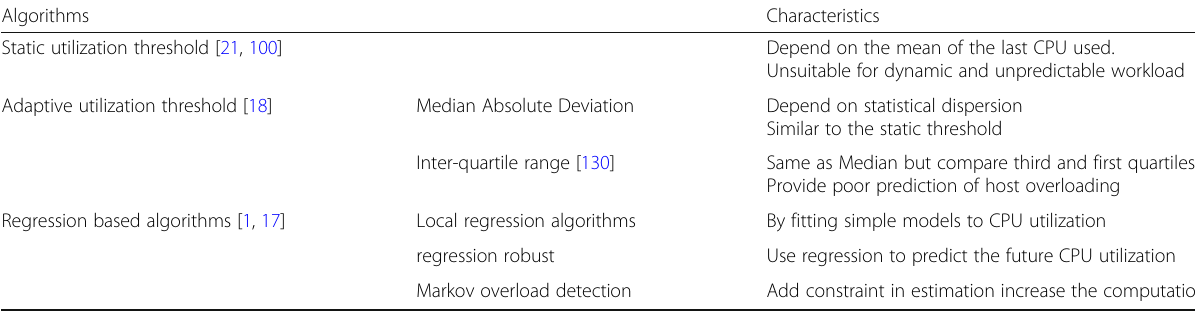
Table 3 Host overload detection algorithms